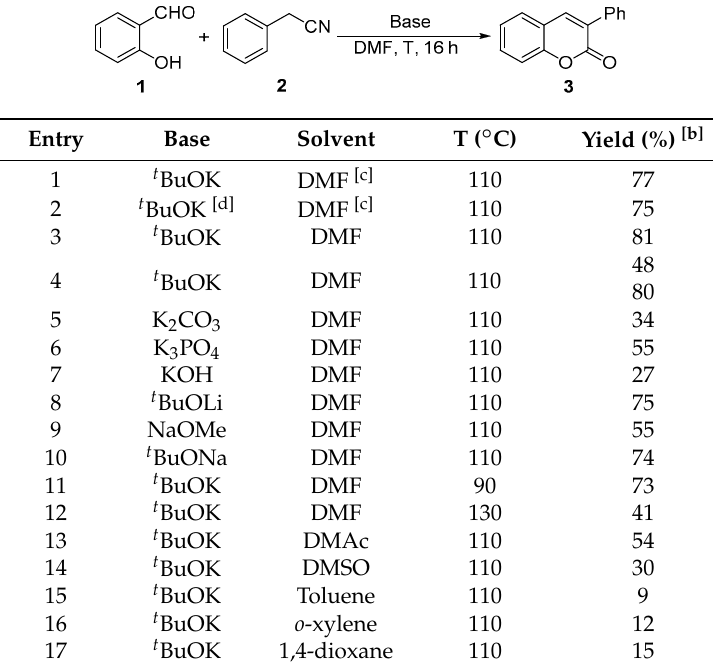
Table 1. Optimization of the reaction conditions [a] .